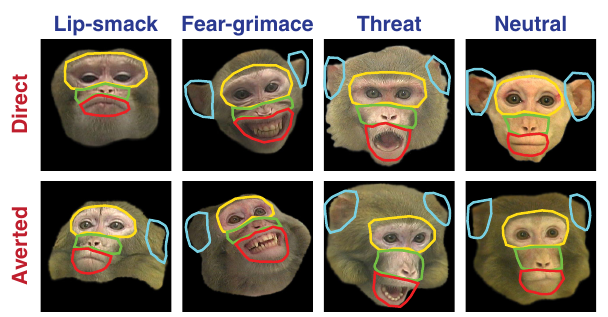
FIGURE 1 | Examples of face stimuli. Columns and rows indicate facial expression and direction of gaze, respectively. Each colored contour encloses one of four main facial regions, eye (and brow), mouth, nose, and ears. For each feature, visitation was quantifi ed by scoring time spent looking within the